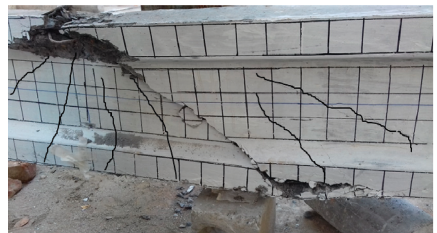
Figure 19: Crack patterns of B5-SFRC-1.